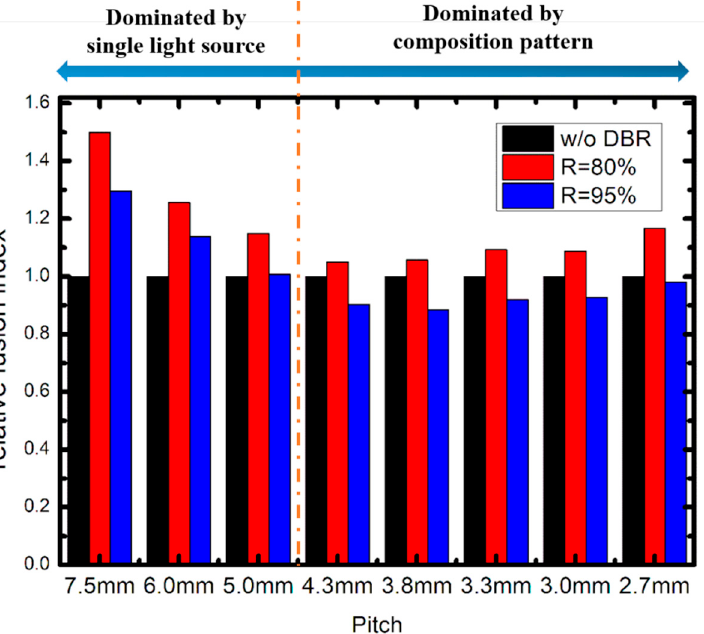
Figure 6. Fusion index of mini light-emitting diode array with various distributed Bragg reflector (DBR) structures.